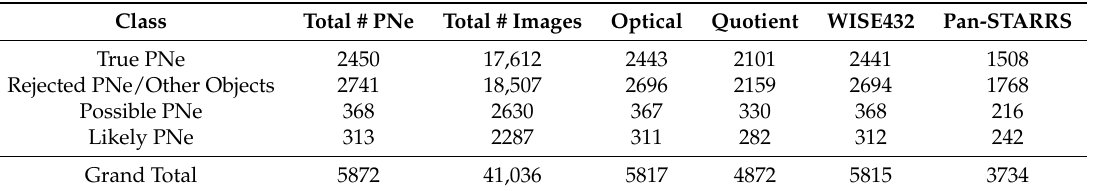
Table 1. Distribution of True PNe, Rejected PNe/Other Objects, Possible PNe and Likely PNe alongside their respective image resources from the HASH DB.